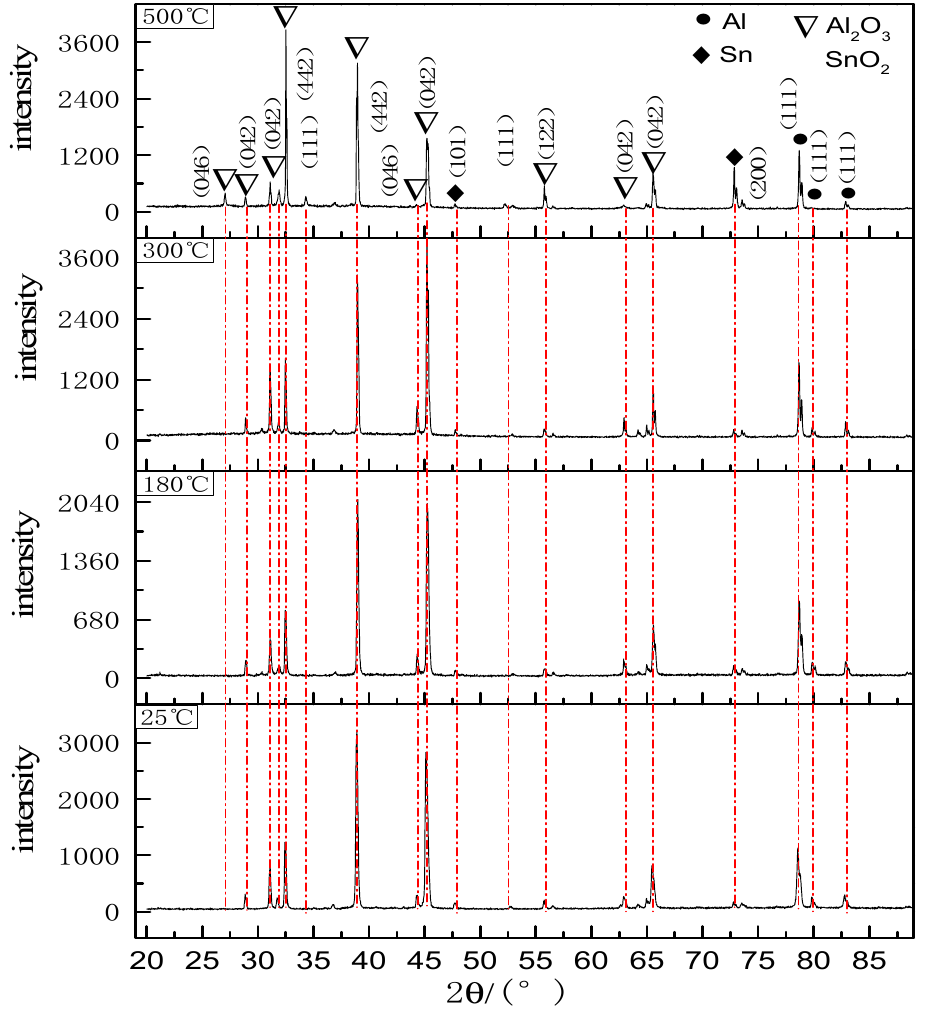
Figure 7. XRD spectra of oxide film at different temperatures (t = 12 h).